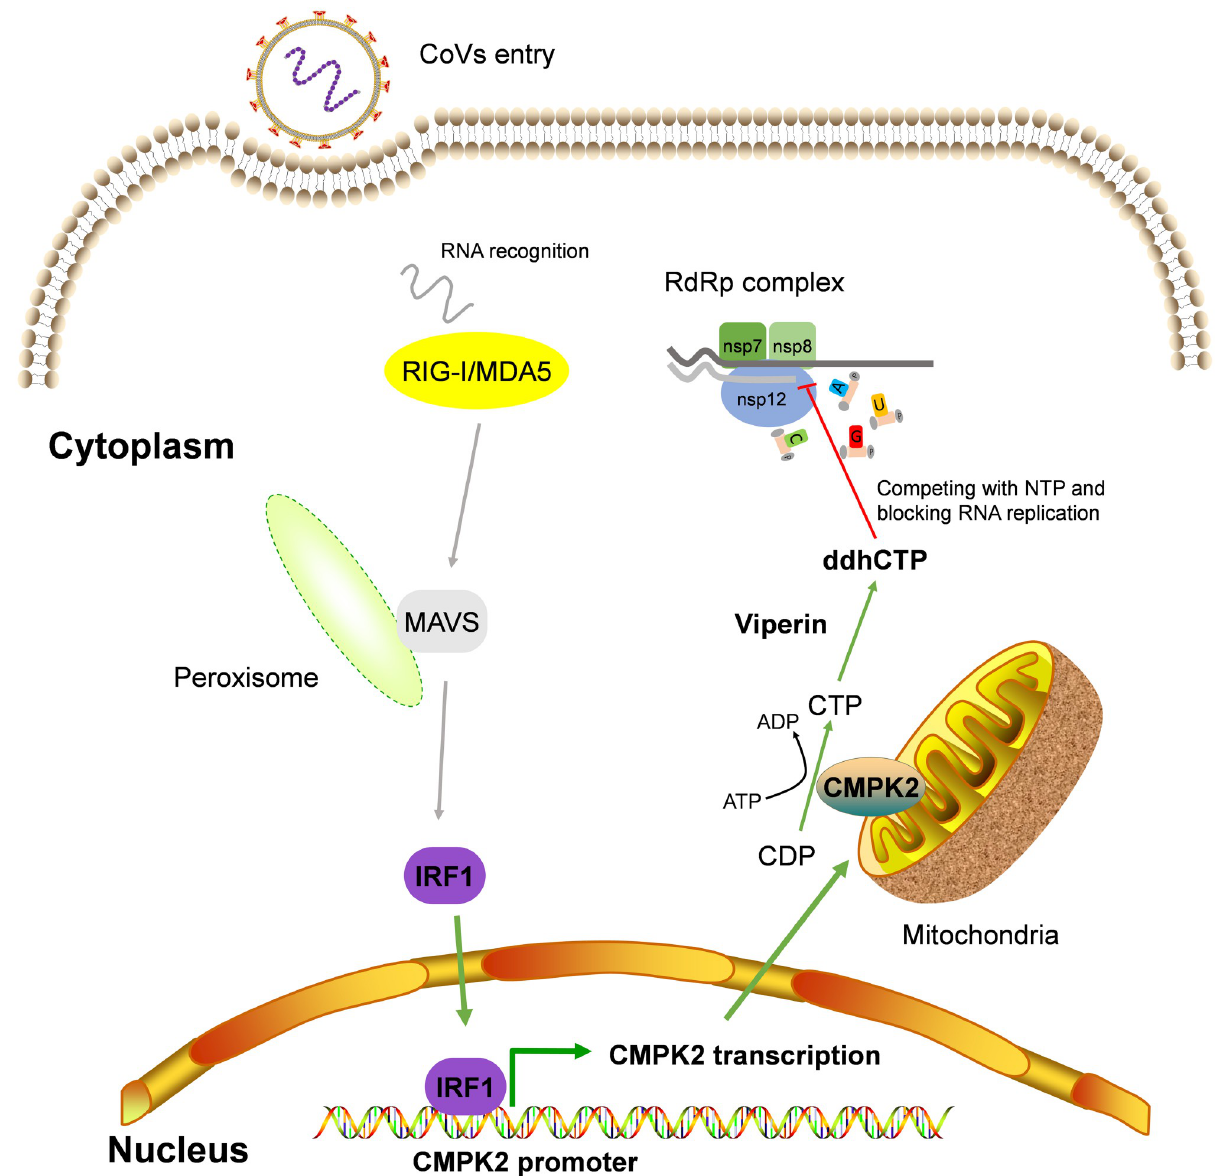
Fig 9. The graphical depiction of CMPK2 inhibition of CoVs replication by interfering with their RdRp activities. Upon CoV infection, IRF1 directly induces CMPK2 expression independently of the IFN-I pathway. CMPK2 localizes in mitochondria and provides sufficient substrate for Viperin-catalyzed production of ddhCTP through catalyzing the phosphorylation of CDP to produce CTP. Subsequently, ddhCTP directly stalls the progression of viral polymerase by competing with natural ribonucleotides. CMPK2, cytidine/uridine monophosphate kinase 2; CoV, coronavirus; ddhCTP, 3 0 -deoxy-3 0 ,4 0 -didehydro-cytidine triphosphate; IFN-I, type I interferon; IRF1, interferon regulatory factor 1; RdRp, RNA-dependent RNA